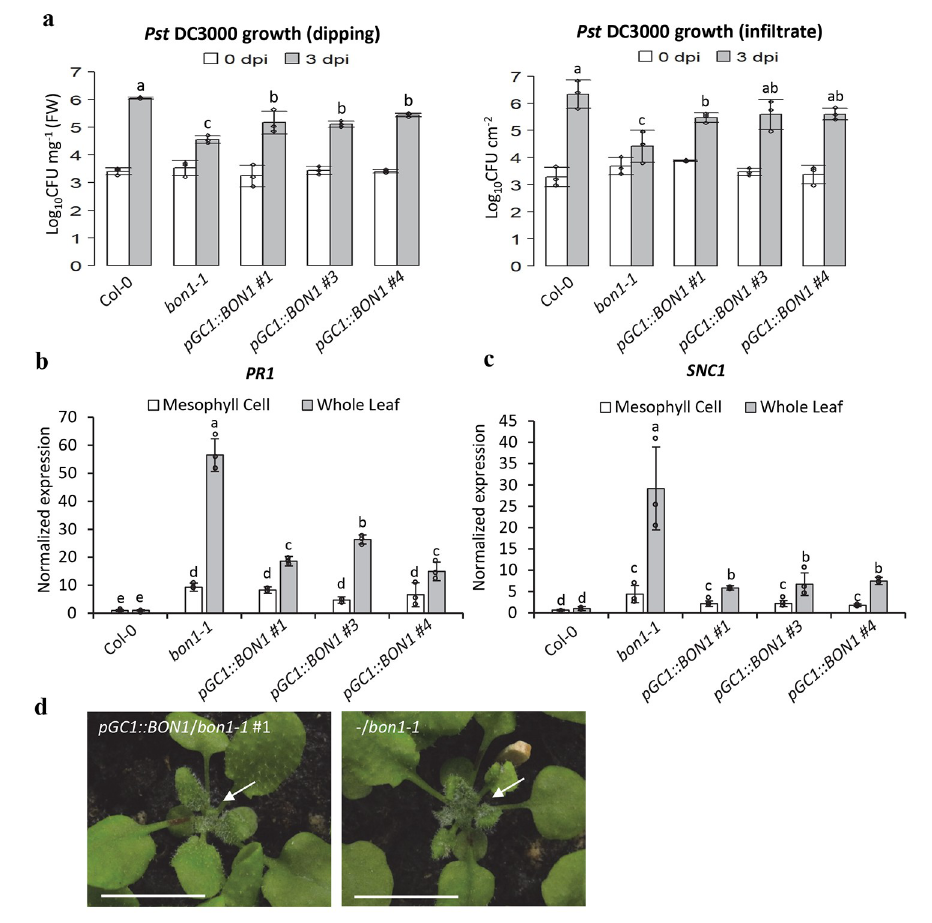
Fig 7. Expressing BON1 in guard cells reduces autoimmunity in bon1-1 . ( a ) Growth of Pst DC3000 at 0 dpi and 3 dpi after dipping or syringe-infiltration. Results are from three biological repeats in one experiment representative of two independent experiments. Error bars indicate SDs (n = 3). Different letters indicate statistically significant differences in pathogen growth between different genotypes ( p < 0.05, student’s t test). ( b , c ) Transcript abundance of PR1 ( b ) and SNC1 ( c ) in mesophyll cells and whole leaves assayed by quantitative Real-time PCR (qPCR). Plants were grown for 5 weeks at 22˚C and RNA was harvested from mesophyll cells or rosette leaves, respectively. Results represent three biological replicates. The expression of target genes was normalized to reference gene ACTIN , and relative to their expression in whole leaves of Col-0 which was set as 1. Values are arithmetic means ± standard error (S.E.). Different letters indicate statistically significant differences between indicated plant lines ( p < 0.05, based on one-way ANOVA followed by Duncan’s new multiple range test). ( d ) Growth phenotype of 4-week-old plants from the T2 generation of pGC1 :: BON1/bon1 transgenic line grown at 22˚C, 12h/12h L/D. White arrows point to the flat or twisted young leaves of the T2 plants with (left panel) or without (right panel) the pGC1 :: BON1 transgene respectively (Scale bar = 1